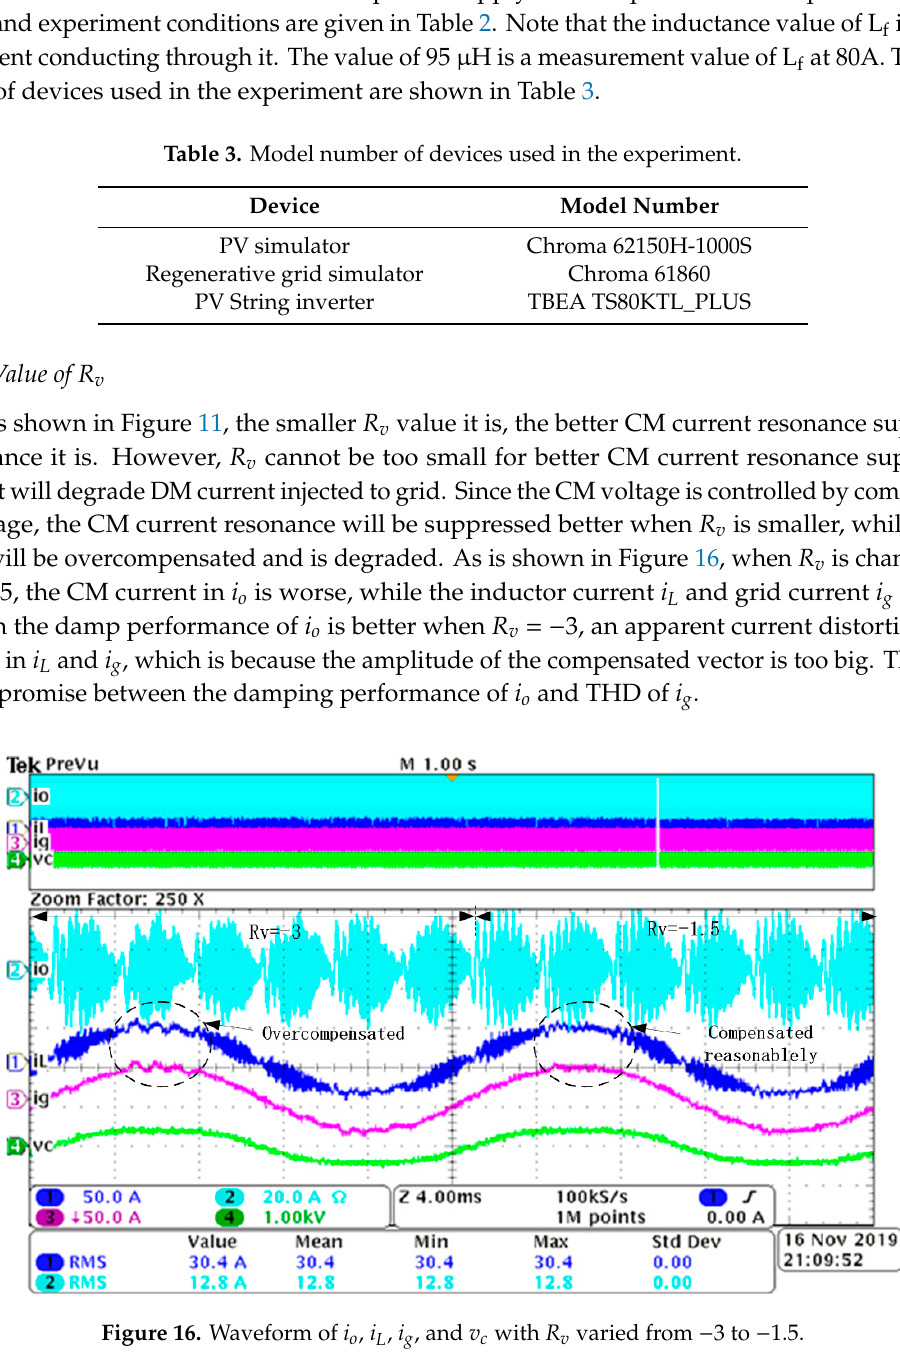
Figure 17. Waveform comparison of i o , i L , i g , and v c between AD and without AD under 60A i L.